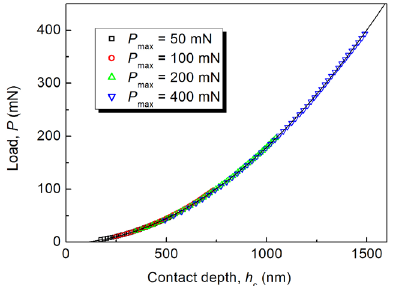
Fig. 6 Relationship between load P and contact depth h c calculated with the experimental data given in Fig.